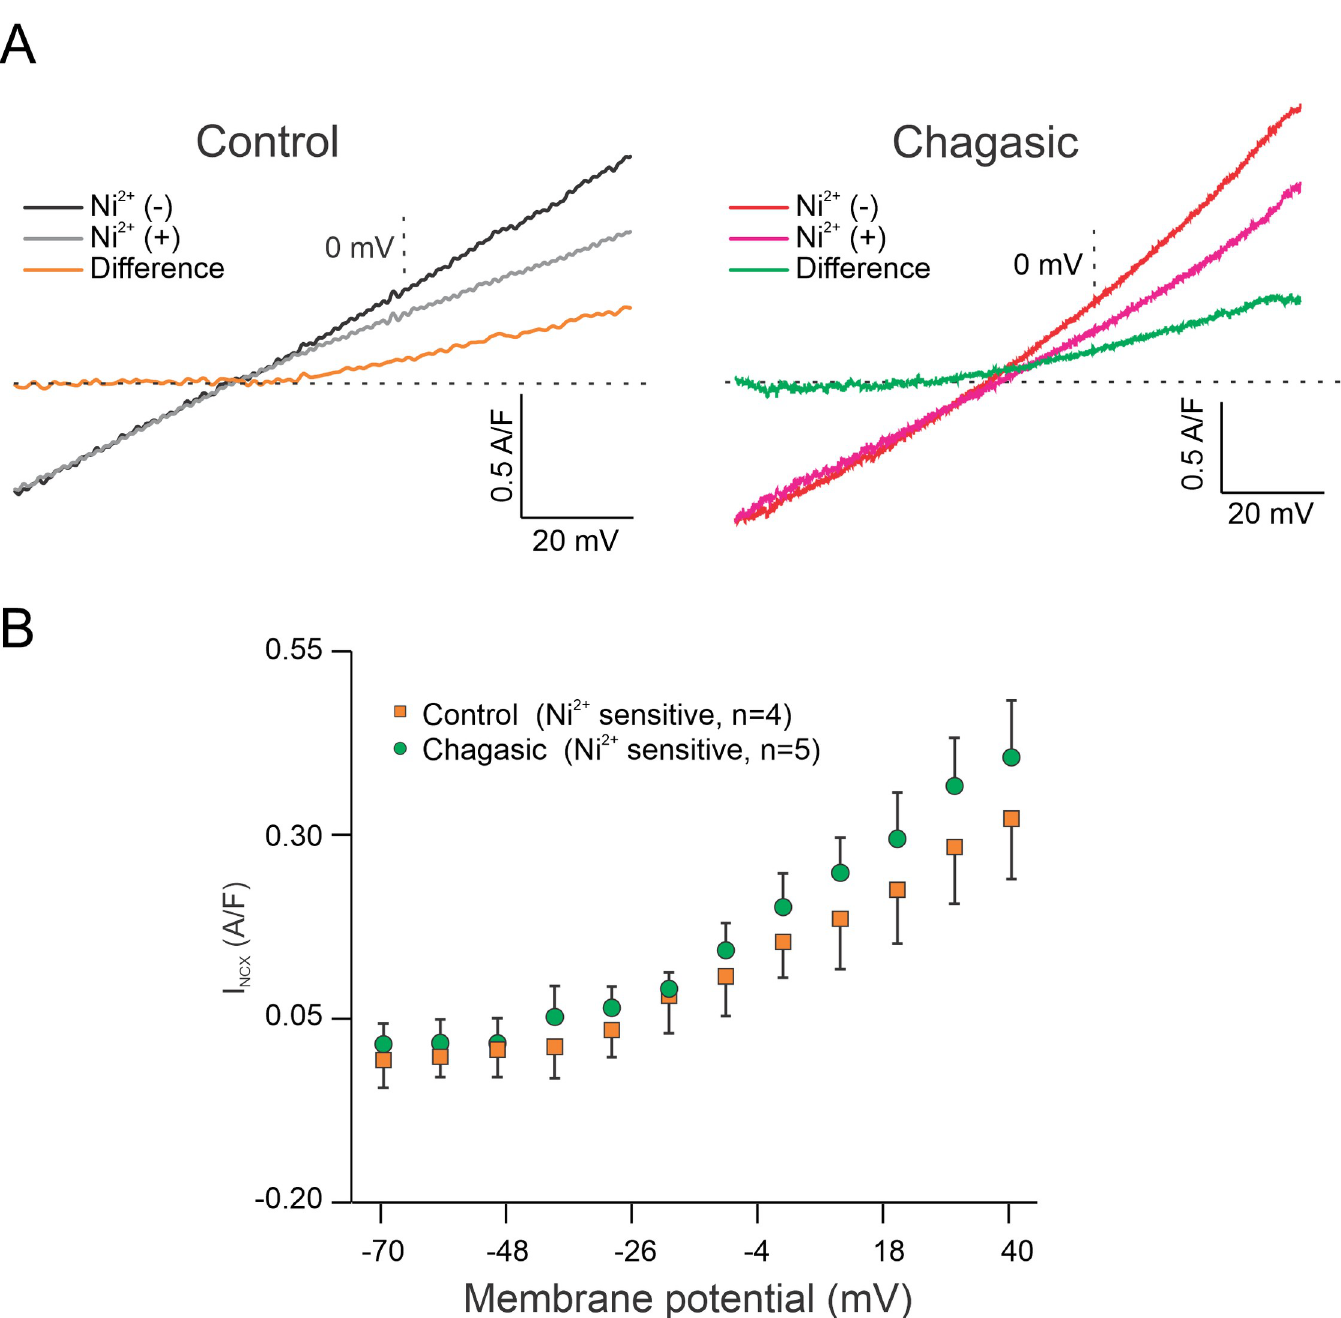
Fig 8. Ni 2+ -sensitive Na + /Ca 2+ exchange current (I NCX ) density does not change in experimental Chagas disease. (A) Representative I NCX vs. Membrane Potential relationships before (Ni (-)) and after (Ni (+)) perfusion of 5 mM Ni 2+ measured in isolated cardiomyocytes from control (Panel A, left) and infected (Panel A, right) mice. Orange and green traces represent the difference current obtained by digitally subtracting traces before and after Ni 2+ application. (B) Average Ni 2+ -subtracted Current Density versus Membrane Potential in control (orange squares) and chagasic (green circles) cardiomyocytes were not different. Data were analyzed using Two- way ANOVA. n indicates the number of